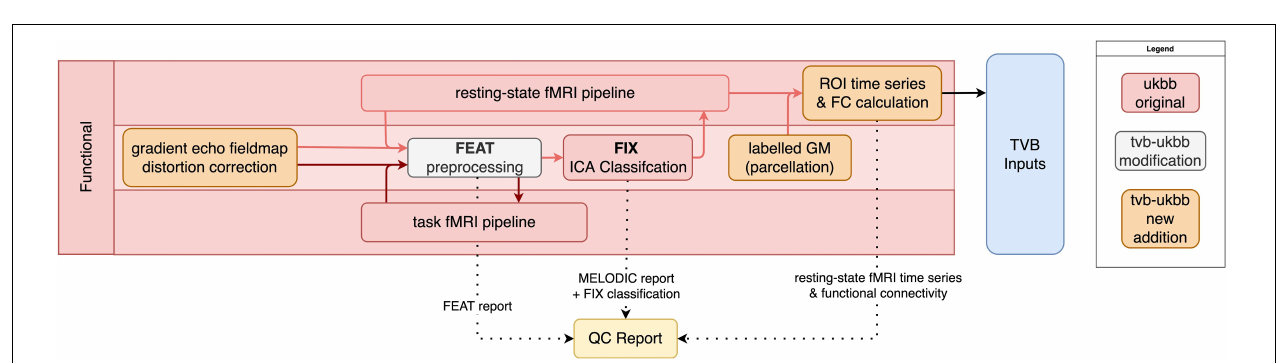
FIGURE 2 | Structural sub-pipeline workflow. Original components of the UK Biobank pipeline with few or no modifications are in green; pipeline components with major changes or additions are indicated in white; and new components are indicated in orange. Dotted lines indicate components that are included in the QC report. Black lines indicate components that are used downstream by other sub-pipelines or included in “TVB Inputs.” GM, gray matter; WM, white matter.